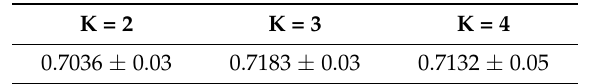
Figure 1. Prediction performance of KATZ-YC with different parameter settings (k = 2, 3 and 4) in terms of the receiver–operating characteristics (ROC) curve and area under the curve (AUC), based on K-fold cross validation: ( a ) based on Leave One Out Cross Valication (LOOCV); ( b ) based on 2-fold cross validation; and ( c ) based on 5-fold cross validation. Table 2. Performance comparison among different parameter settings (k = 2, 3, 4) in the framework of 2-fold cross validation.